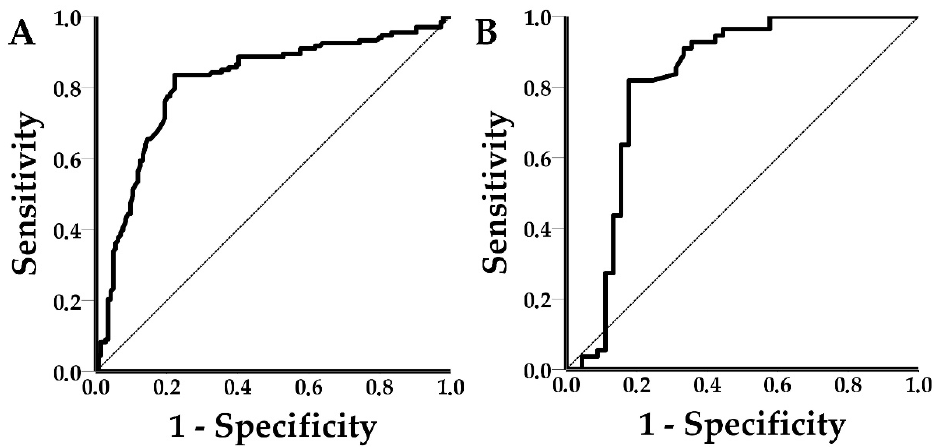
Figure 6. ( A ) PRRSV ROC curve, AUC: 0.812, 95% CI: 0.759–0.866, p < 0.0001 and ( B ) SIV ROC curve, AUC: 0.816, 95% CI: 0.719–0.912, p < 0.0001.